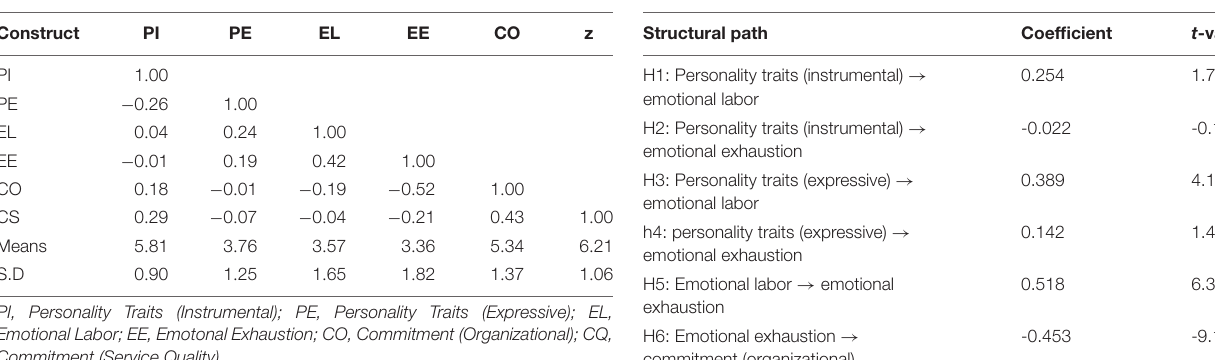
TABLE 4 | Construct means, standard deviations, and correlations. TABLE 5 | Structural models